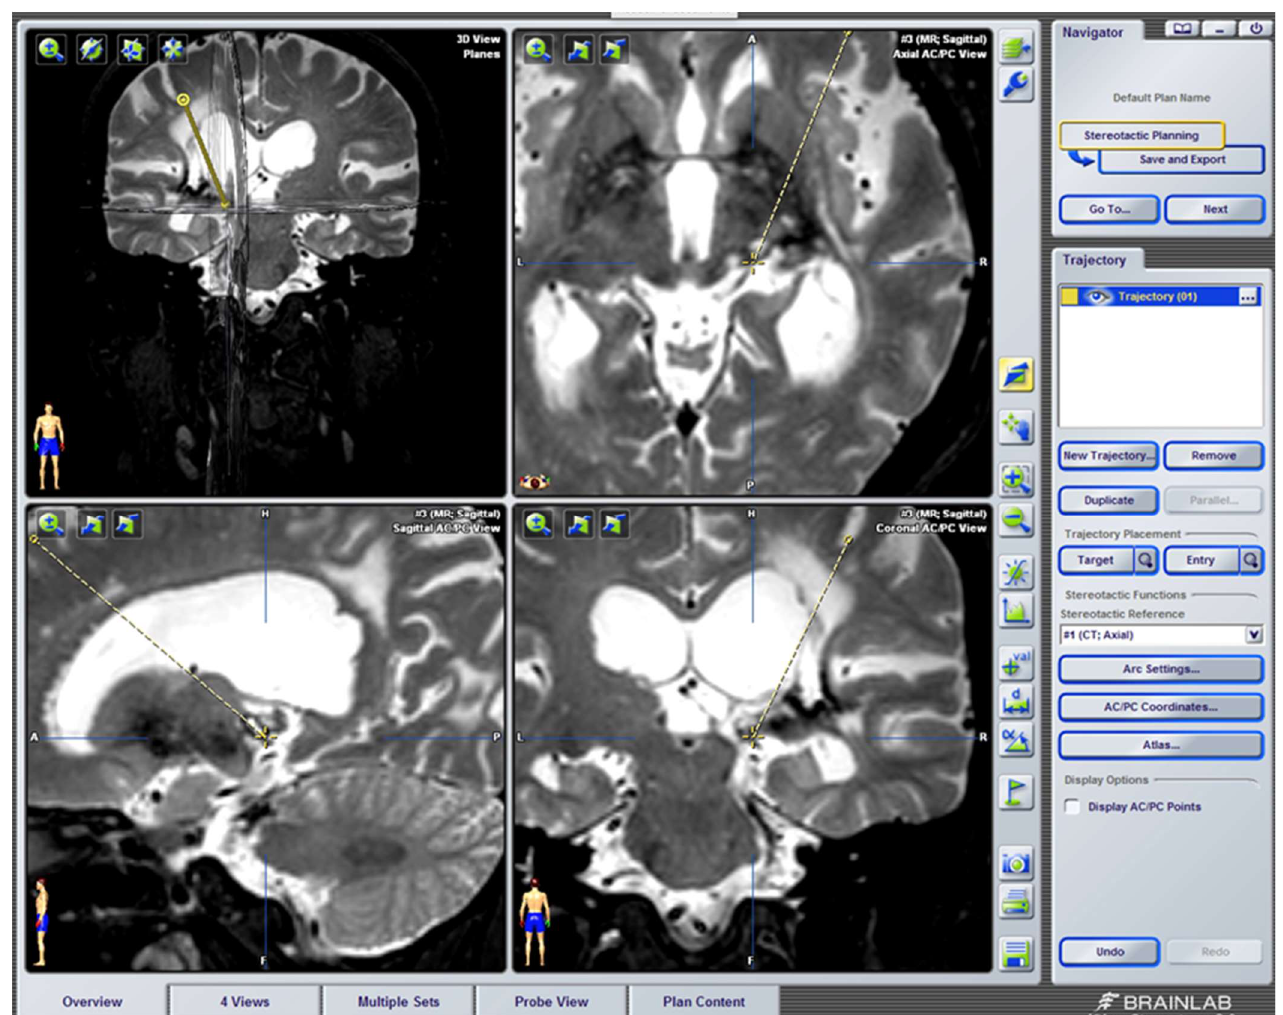
Figure 16. DBS at the level of the VPL nucleus in a female patient with Dejerine syndrome, with more disabling pain in the right lower extremity, on the sole of the foot. It prevented her from walk- ing. She has reported good results for more than 5 years. Within the coordinates of the VPL nucleus, an area without hypointensity was located in T2, obtaining a sensory response to stimulation in the pain